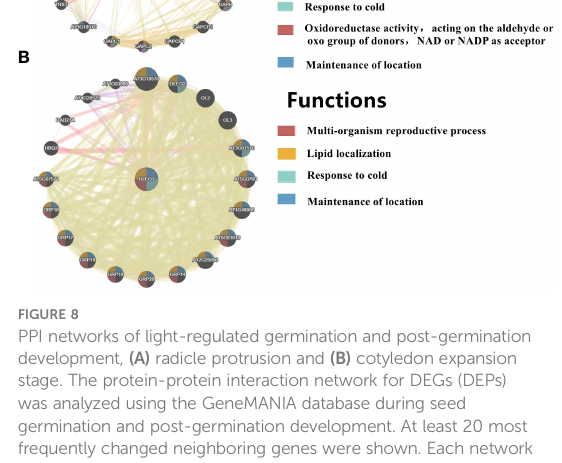
FIGURE 8 PPI networks of light-regulated germination and post-germination development, (A) radicle protrusion and (B) cotyledon expansion stage. The protein-protein interaction network for DEGs (DEPs) was analyzed using the GeneMANIA database during seed germination and post-germination development. At least 20 most frequently changed neighboring genes were shown. Each network node represented a gene. The node color represented the possible functions of these respective